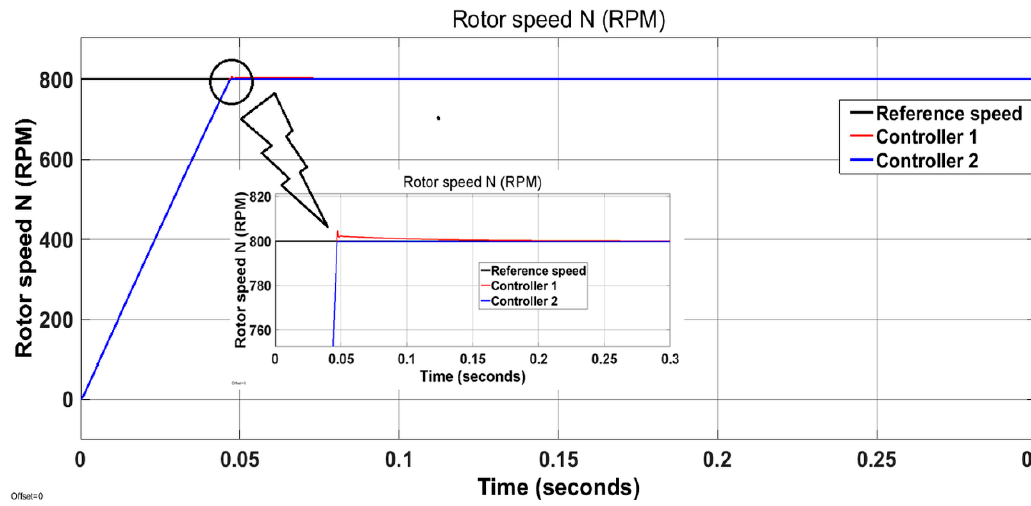
Figure11. Rotorspeedofthetwodi ff erentcontrollersfollowingthespeedprofile, anditsexpandedview. Figure 11. Rotor speed of the two different controllers following the speed profile, and its expanded view.